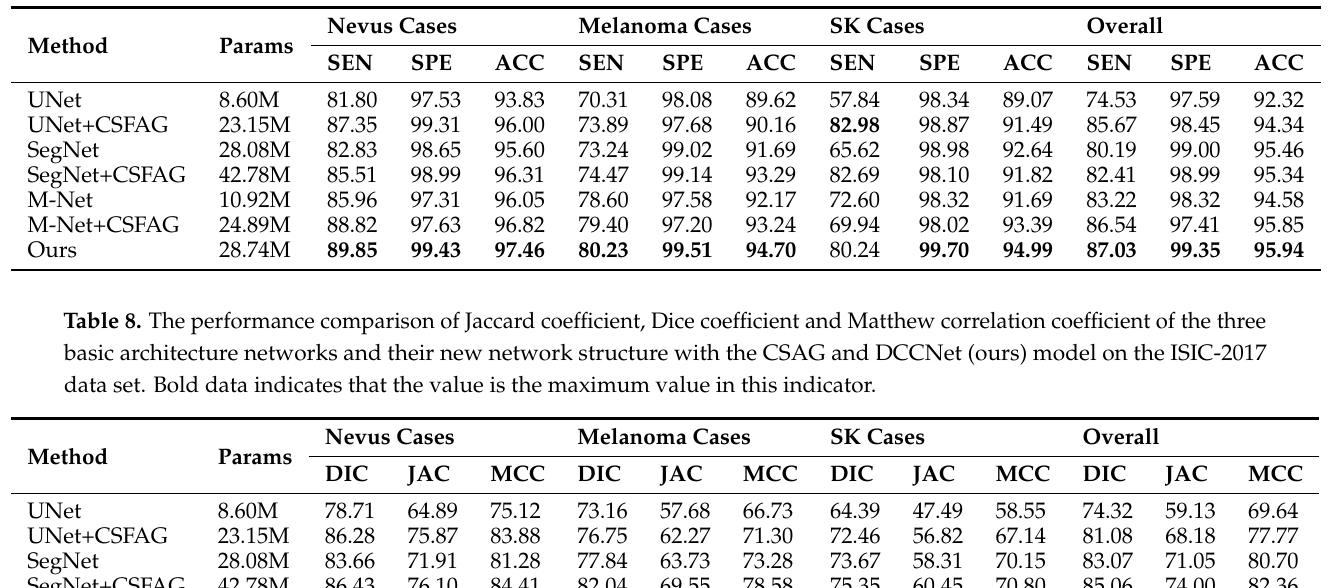
Table 7. The performance comparison of sensitivity, specificity and accuracy of the three basic architecture networks and their new network structure with the CSAG and DCCNet (ours) model on the ISIC-2017 data set. Bold data indicates that the value is the maximum value in this indicator.